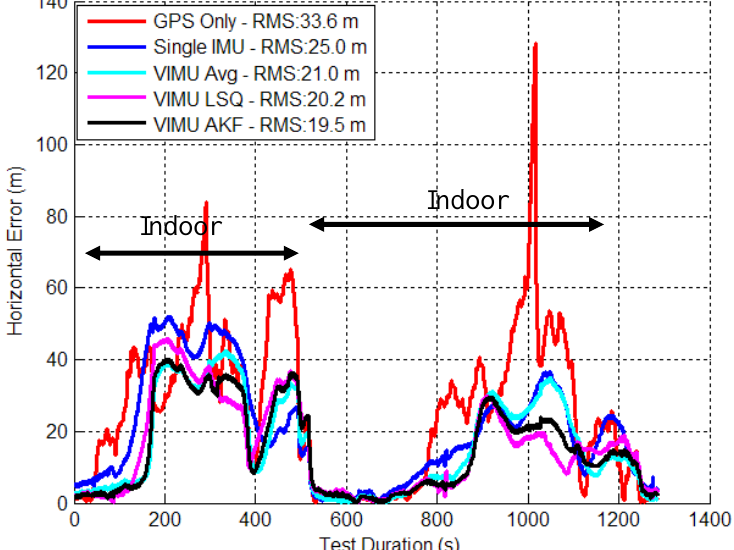
Figure 13. VIMU Horizontal Errors (Five IMUs Used in Olympic Oval Data Set).